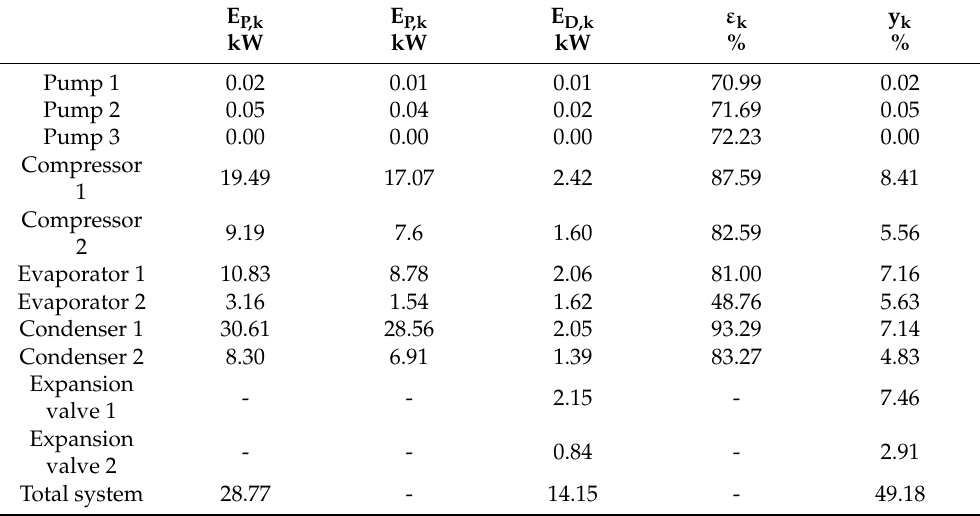
Table A5. Exergy calculation results of case B.